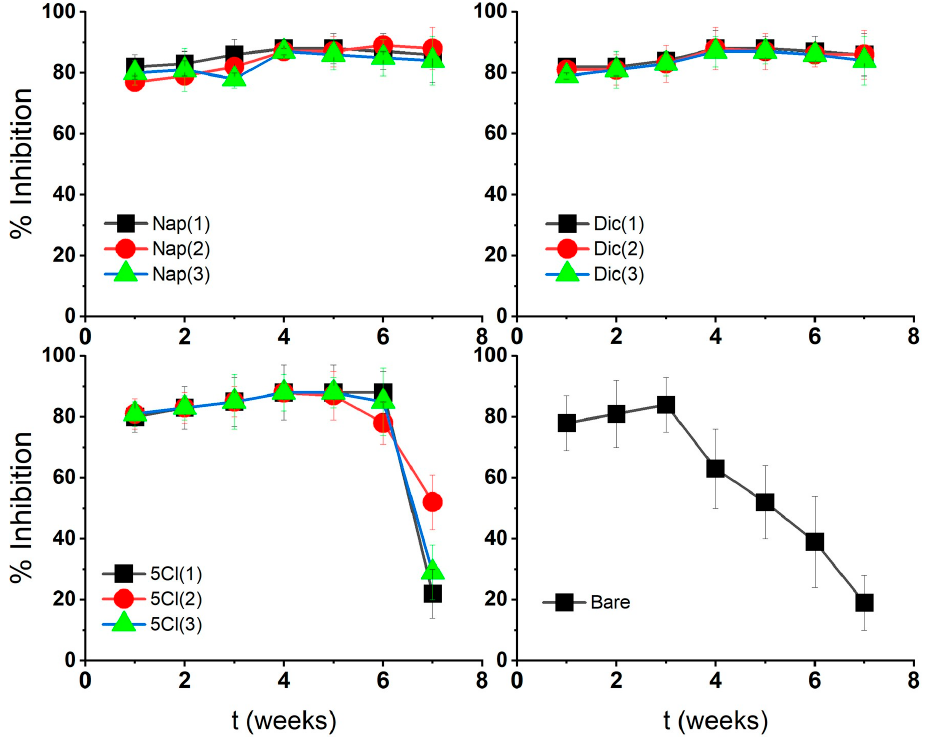
Figure 5. Antibacterial activity over time of silver nanoparticles against Staphylococcus aureus